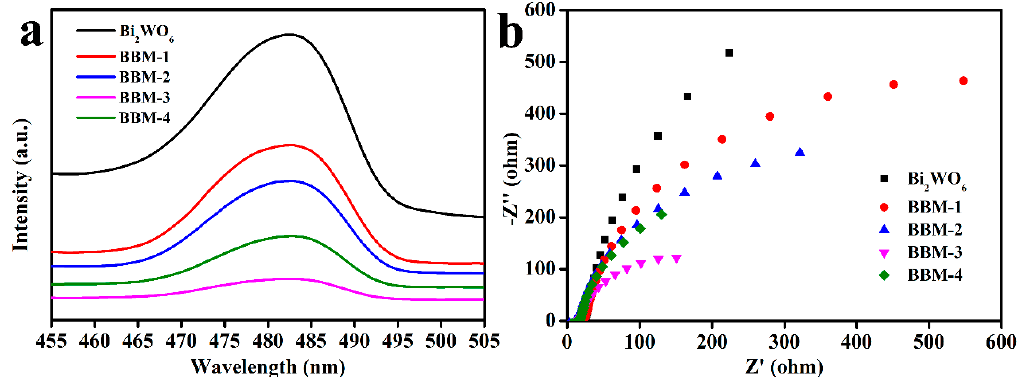
Figure 5. ( a ) Photoluminescence spectra ( λ excitation = 300 nm) and ( b ) electrochemical impedance spectra (EIS) spectra of the Bi 2 WO 6 , BBM-1, BBM-2, BBM-3, and BBM-4.